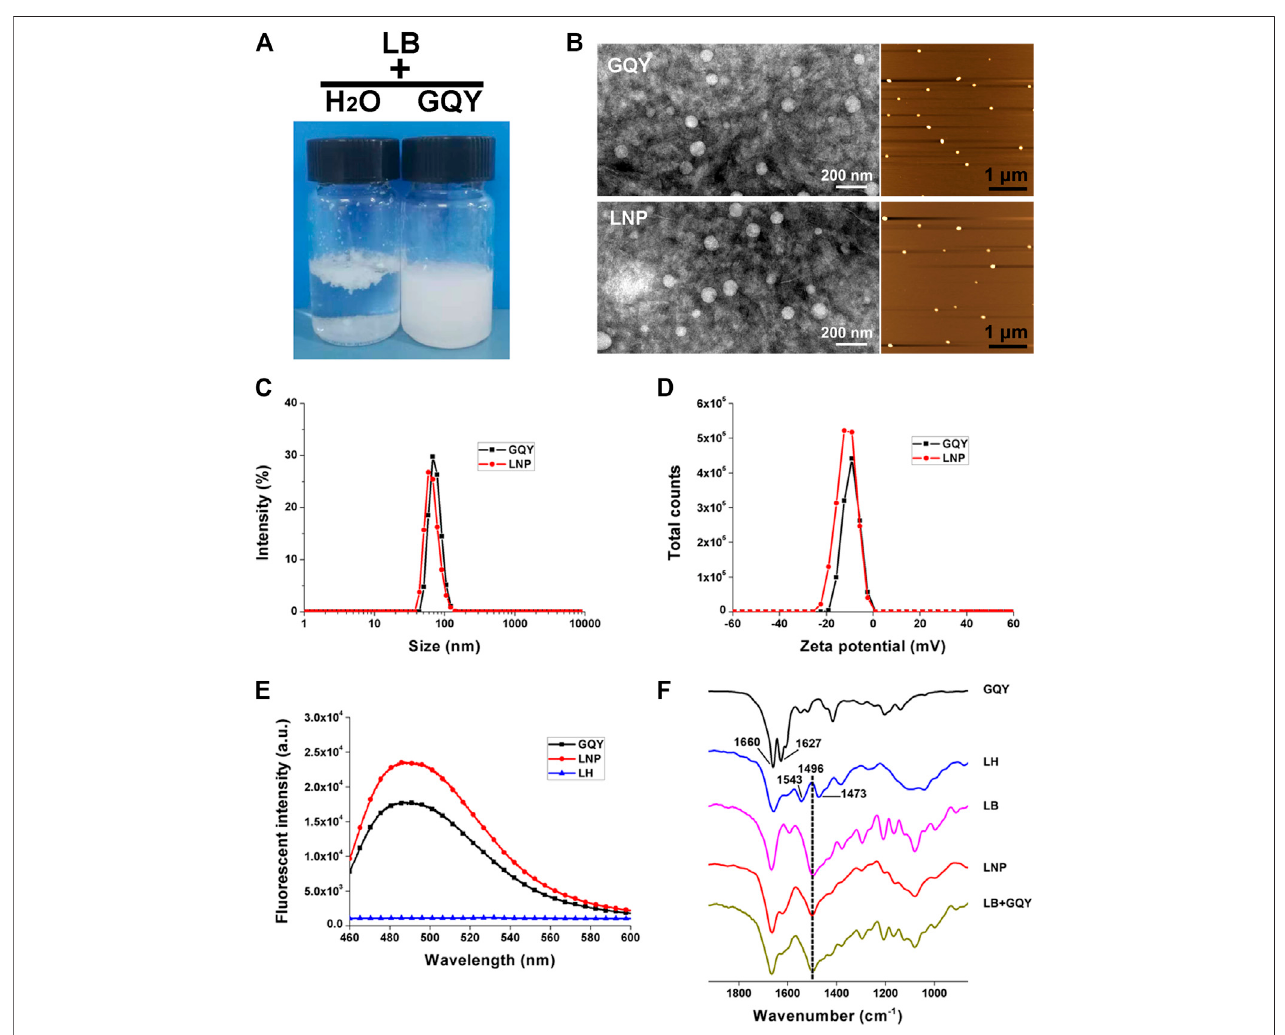
FIGURE 1 | Characterization of LNPs. (A) photo pictures of LB dispersed in water (left) or in GQY (right). (B) TEM (left) and AFM (right) images of empty GQY nanoparticles and LNPs. (C) size distribution of LNPs and empty GQY nanoparticles. (D) zeta potential of LNPs and empty GQY nanoparticles. (E) ThT-binding fl uorescence of GQY, LNPs, and LH. (F) FTIR spectra of GQY, LH, LB, LNP, and LB + GQY.